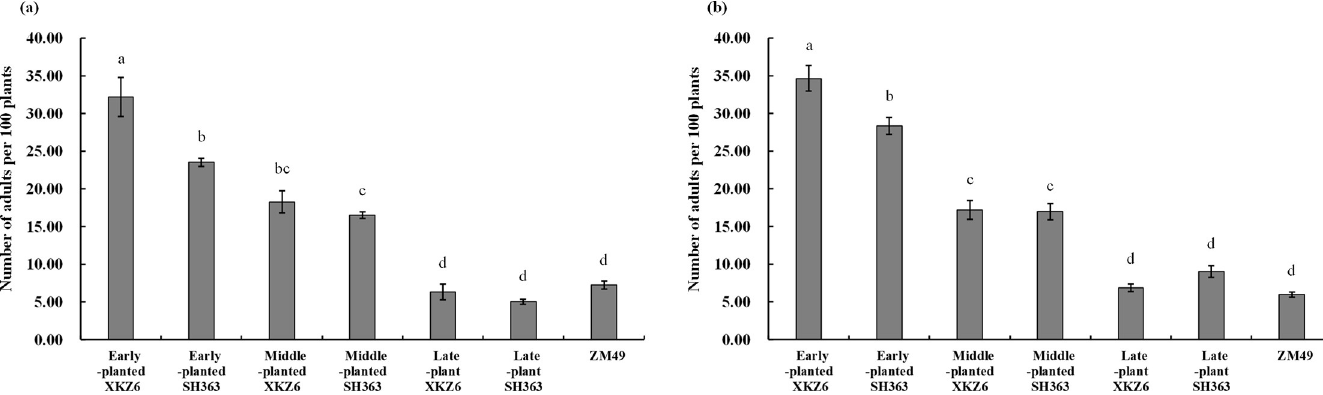
Fig 3. Mean population abundances of Lygus pratensis adults on field plots-established with cotton and sunflower with different planting dates in 2015 (a) and 2016 (b).